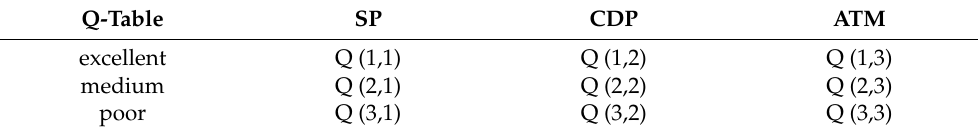
Table 1. The form of Q-table. Q-Table